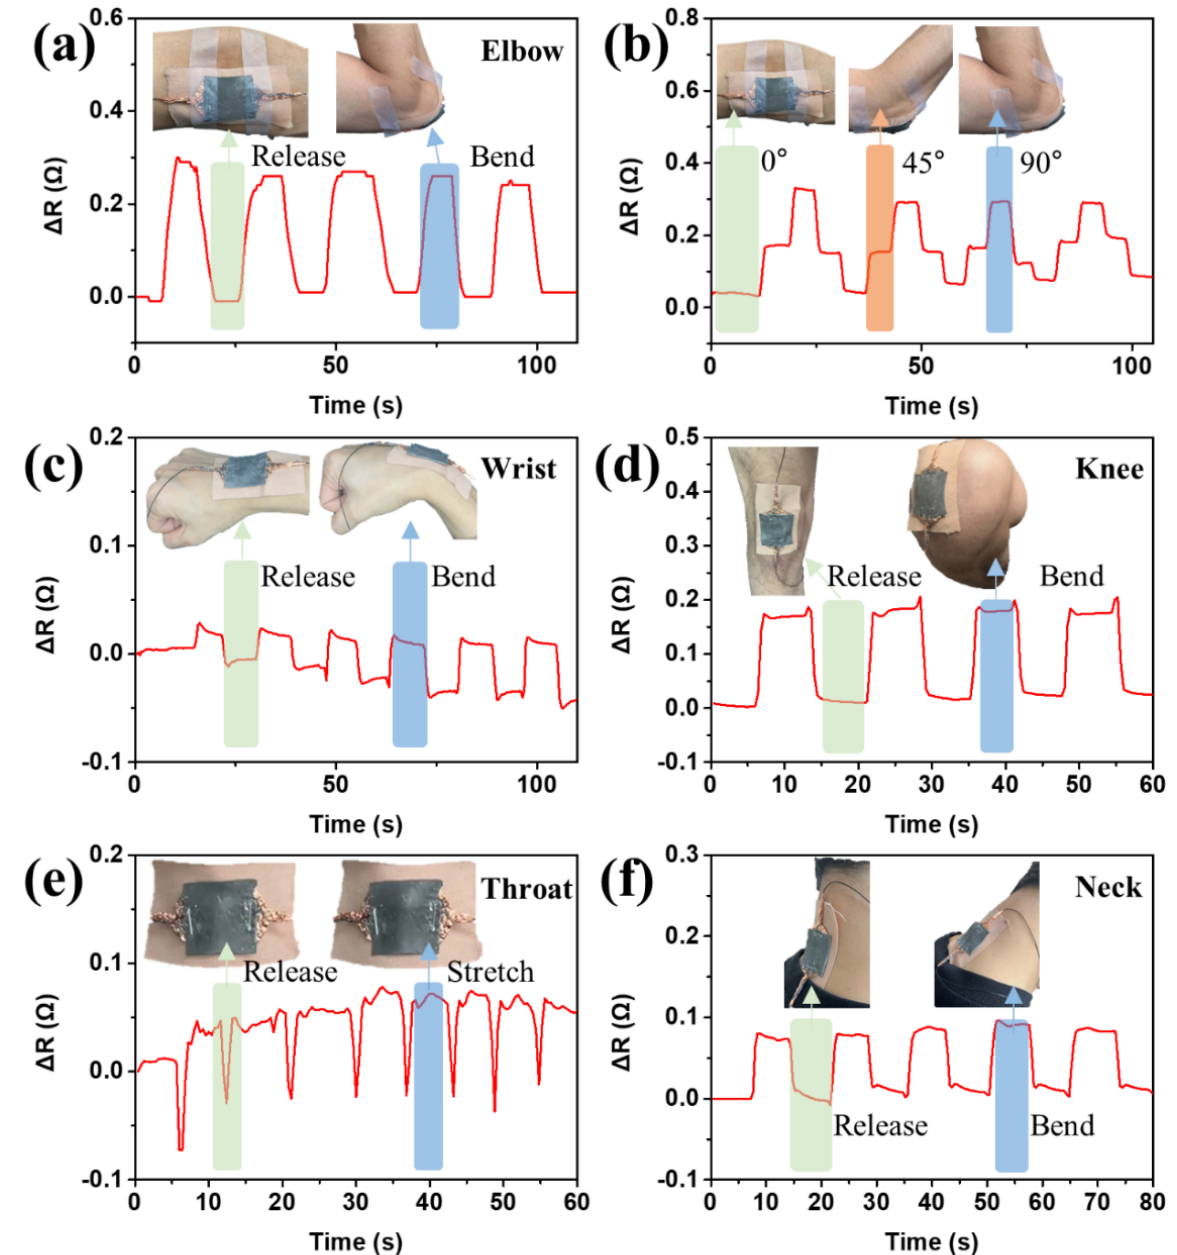
Figure 7. Liquid metal elastomer films utilized soft and wearable strain sensors monitoring various body motions by attaching them to the ( a , b ) elbow, ( c ) wrist, ( d ) knee, ( e ) throat, and ( f ) neck.